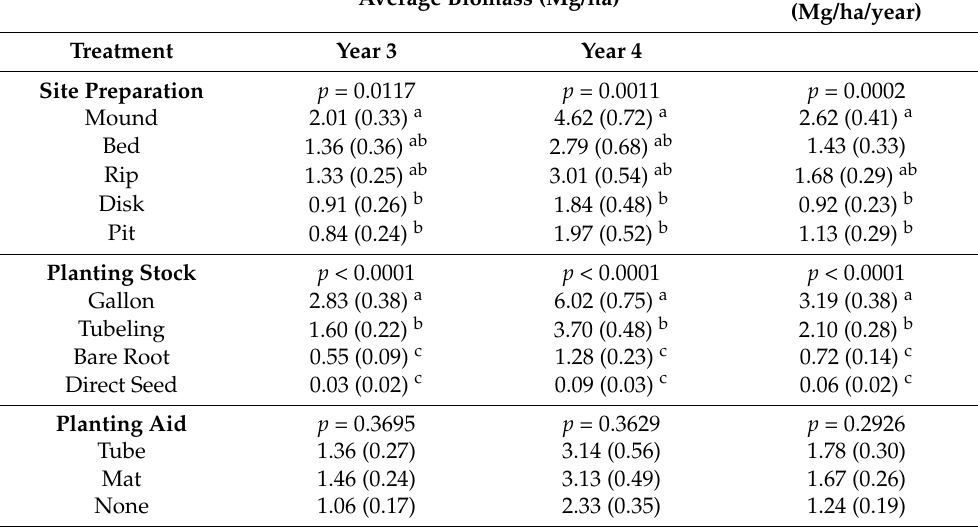
Table 5. Average (Mg/ha) (SE) dry-weight biomass and ANPP wood (Mg/ha/year) for American sycamore in the Virginia Piedmont by site preparation, planting stock type, and planting aid. Values with different letters indicate statistically significant differences according to Tukey’s post hoc HSD ( p < 0.05). Bolded text indicates treatment